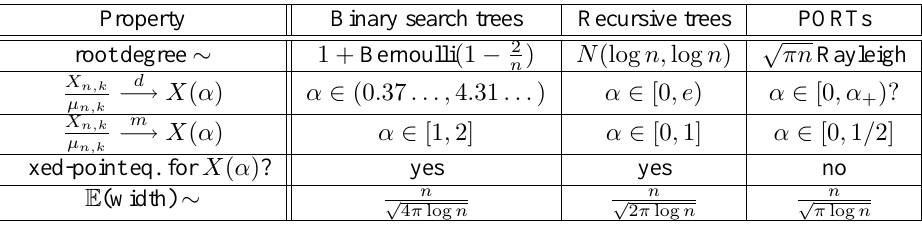
Tab. 2: A comparison of some properties of random binary search trees, recursive trees and PORTs. Here Bernoulli ( p ) denotes a Bernoulli random variable with mean p , N ( µ, σ 2 ) normal with mean µ and variance σ 2 , 0 . 37 . . . and 4 . 31 . . . are the two positive zeros of the equation z = 1 + z log( z/ 2) and the symbol m −→ stands for convergence of all